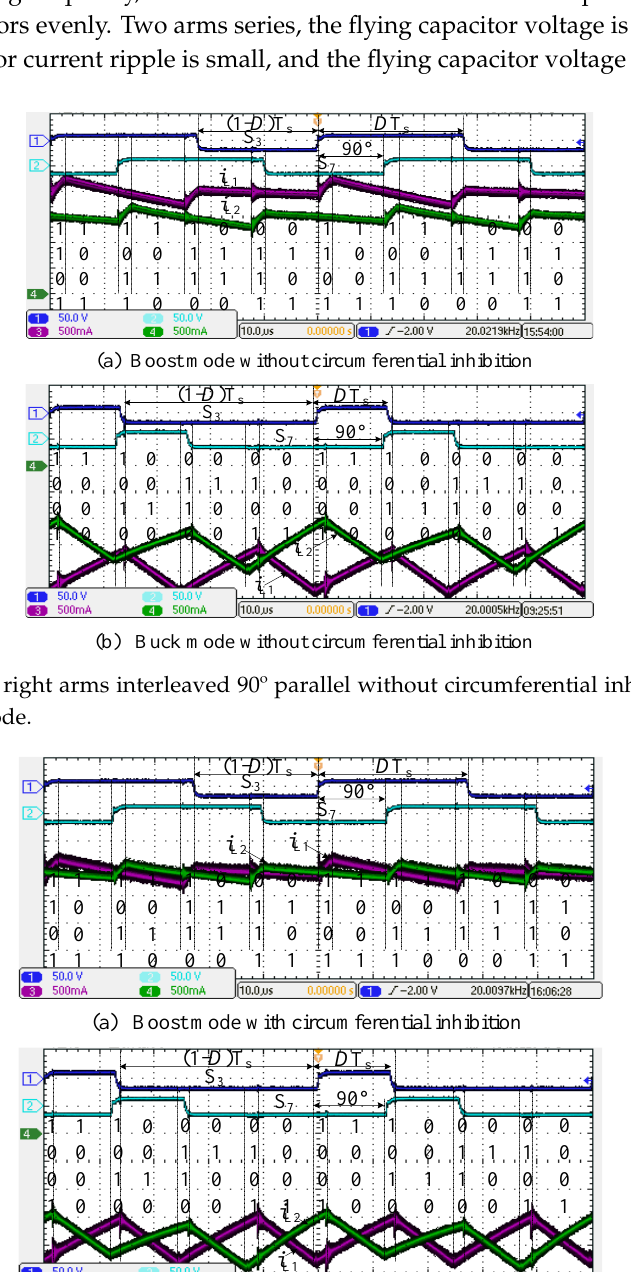
Figure 9. Left and right arms interleaved 90º parallel with circumferential inhibition. ( a ) Boost mode, ( b ) Buck mode.